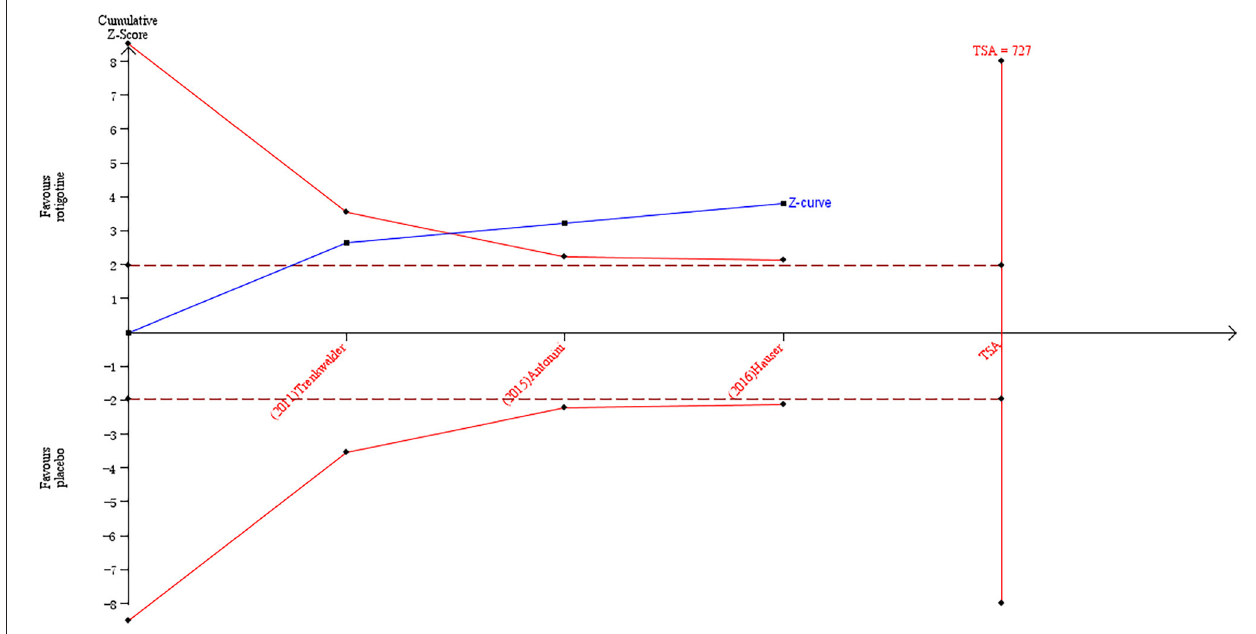
FIGURE 6 | Trial sequential analysis of the cumulative meta-analysis of the effect of rotigotine vs. placebo on the sleep/fatigue score of Parkinson’s Disease Non-motor Symptom Assessment Scale in Parkinson’s disease patients.